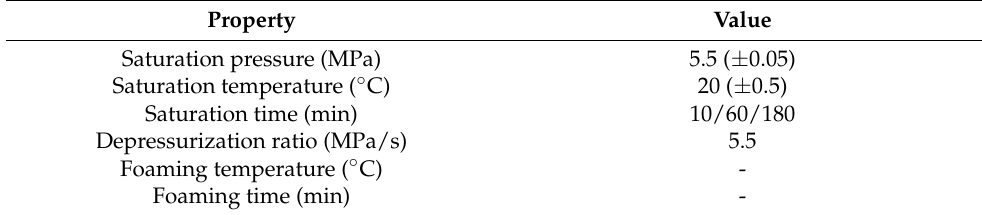
Table 2. Experimental parameters used in this